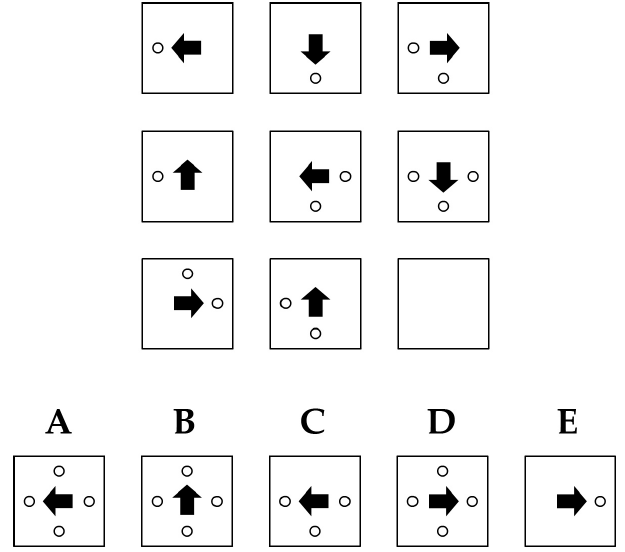
Figure 1. Classic figural matrix item.